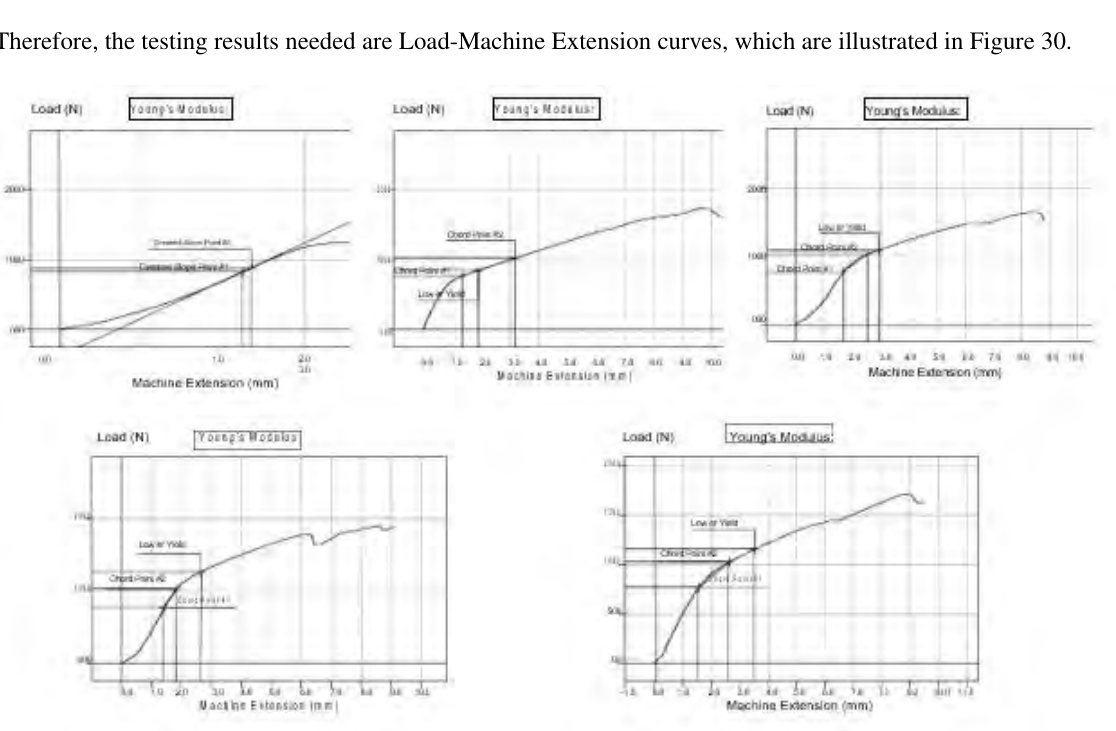
Figure 30. Load-Machine Extension Curves of the 5 specimenin the compressive Modulus of Elasticity (Author’s own,